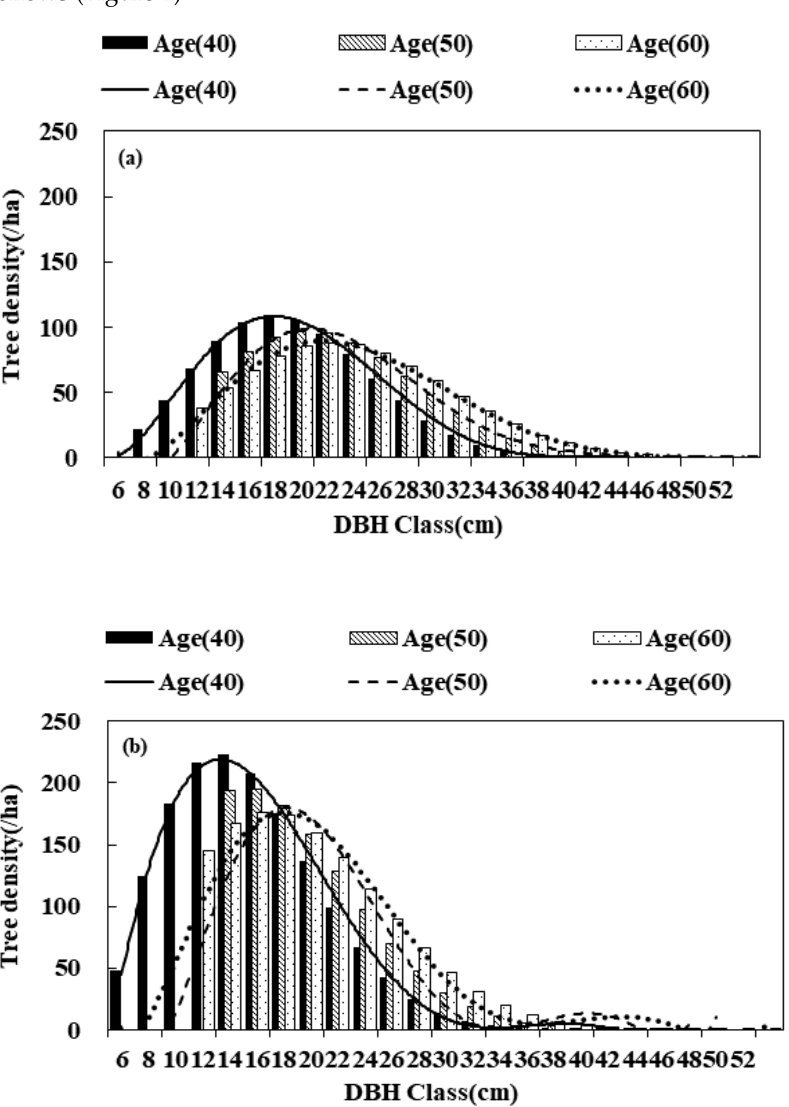
Figure 4. Predicted tree density in ( a ) managed stands and ( b ) unmanaged stands in each DBH class of the following stand ages: 40 years, 50 years, and 60 years.